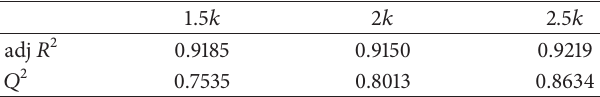
Figure 16: Influence of drive current on electromagnetic force. Table 3: The precision of different model.